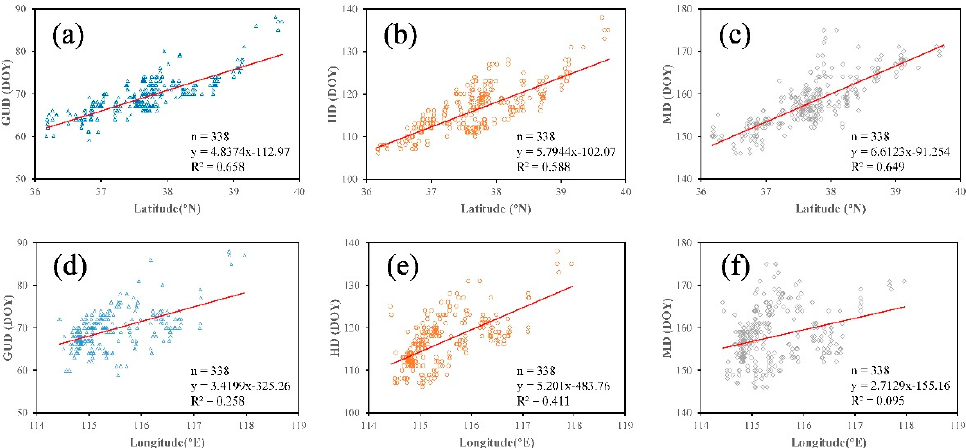
Figure 10. The relationships between ( a ) GUD and latitude ( b ) HD and latitude ( c ) MD and latitude ( d ) GUD and longitude ( e ) HD and longitude, and ( f ) MD and longitude.